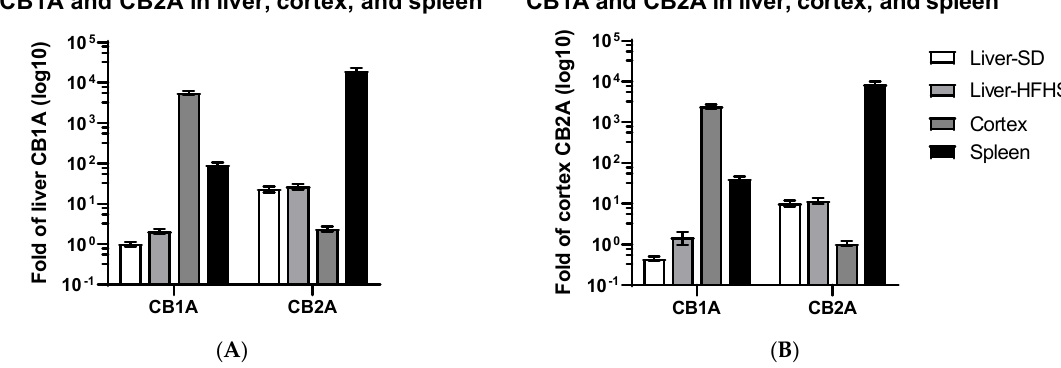
Figure 1. Comparison of low baseline SD ( n = 6) and high-fat/high sugar diets (HFHS) ( n = 6) liver cannabinoid receptors (CB1R) and cortex ( n = 6) CB2R to high baseline cortex CB1R and spleen ( n = 3) CB2R. SD represents standard diet and HFHS high-fat and high sugar diet. ( A ) using SD liver CB1A as a reference and ( B ) using cortex CB2A ( n = 6) as a reference.